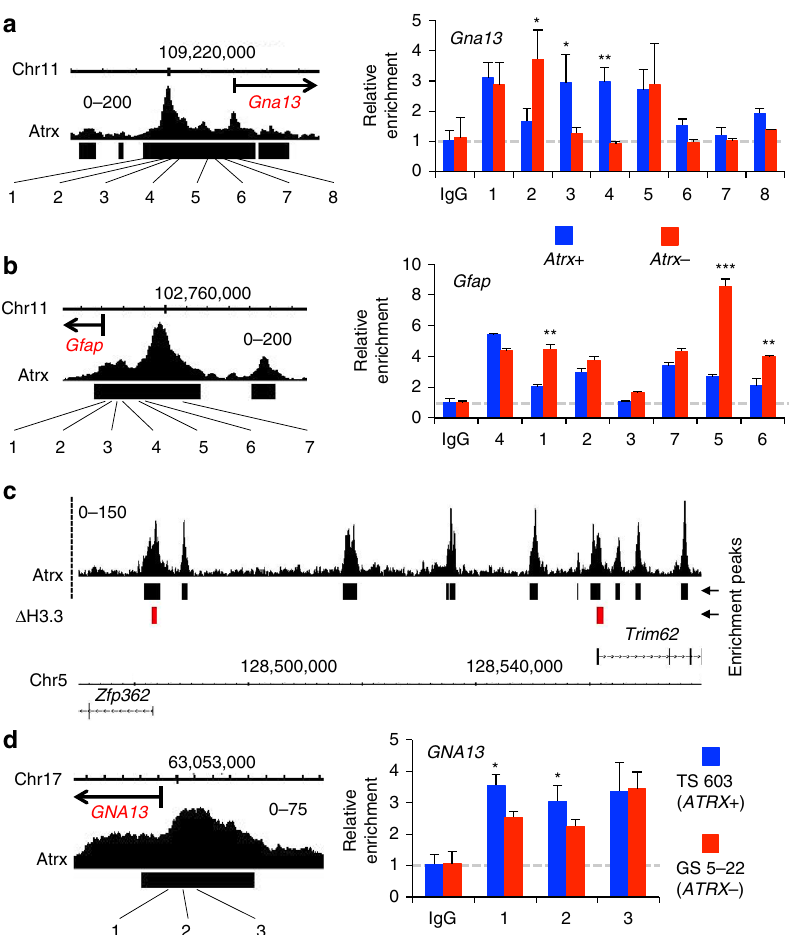
Fig. 8 Atrx-dependent epigenetic and transcriptional alterations correlate with H3.3 composition. a , b H3.3 ChIP qPCR from Atrx-bound genomic loci approximating Gna13 and Gfap reveals differential enrichment between Atrx + and Atrx - mNPCs at many points. Positioning of loci subjected to qPCR relative to Atrx binding peaks and open reading frames ( Gna13 and Gfap ) is also shown (left panels). c sample trace showing relationship of Atrx ChIP-seq peaks (black) to sites of signi fi cantly differential H3.3 composition ( Δ H3.3) arising with Atrx de fi ciency (red). d H3.3 ChIP qPCR from Atrx-bound genomic loci approximating GNA13 reveals differential enrichment between ATRX + (TS 603) and ATRX - (GS 5-22) human GSCs (right panels; * P < 0.05; ** P < 0.001; *** P < 0.0001. In all cases, error bars re fl ect standard deviation and P values determined by unpaired two-tailed t